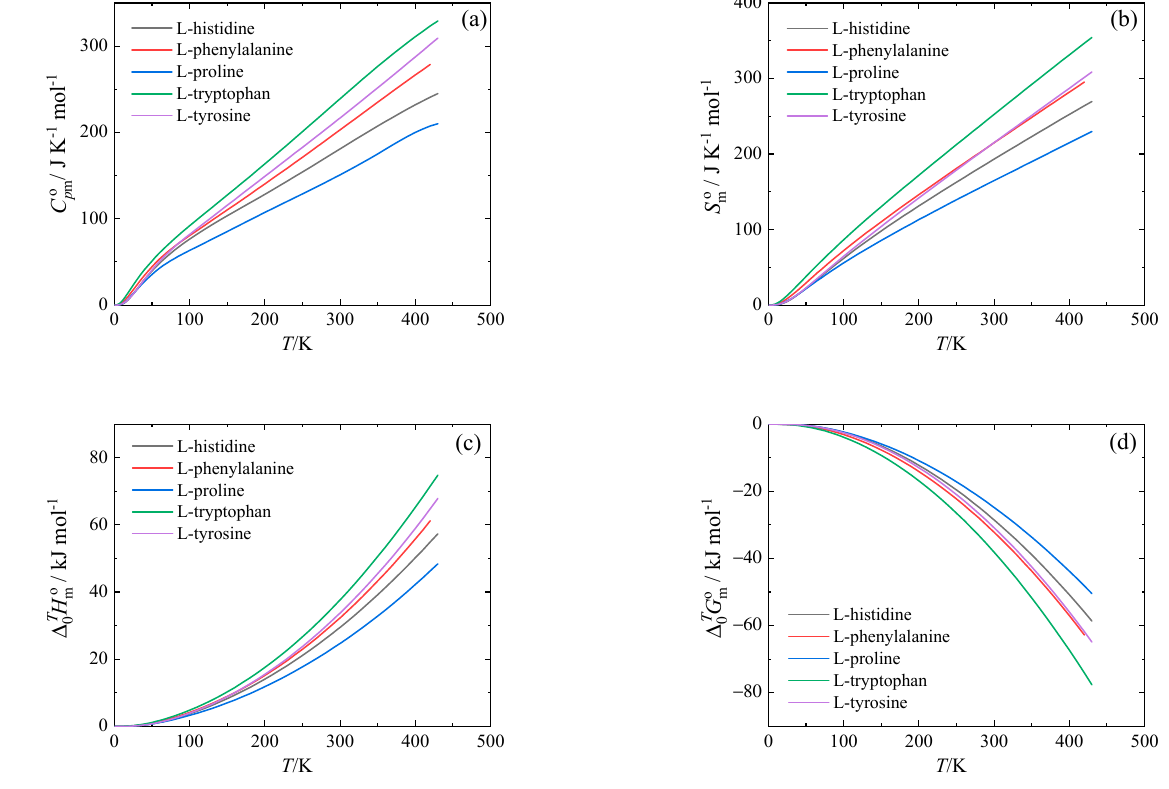
Figure 3. Standard molar thermodynamic functions at p = 0.1 MPa. ( a ) Isobaric heat capacity, ( b ) entropy, ( c ) enthalpy, and ( d ) Gibbs energy.